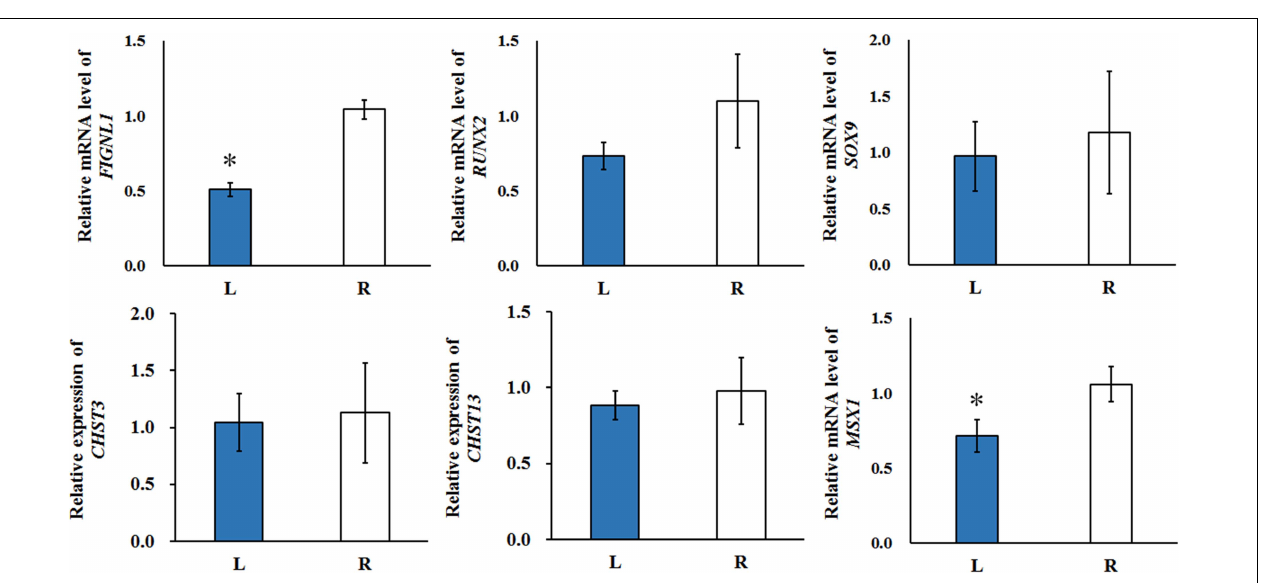
FIGURE 8 | The qRT-PCR was performed to detect the relative mRNA expressions in the left-side (affected-side; L) and the right-side (normal-side; R) mandibular condyle of crossed beak chicks of 7 days-old age with left mandibular curvature. GAPDH was used as internal control. Values are expressed as means ± standard deviation of four replicates. The expression data were analyzed using t -test, ∗ represents p <